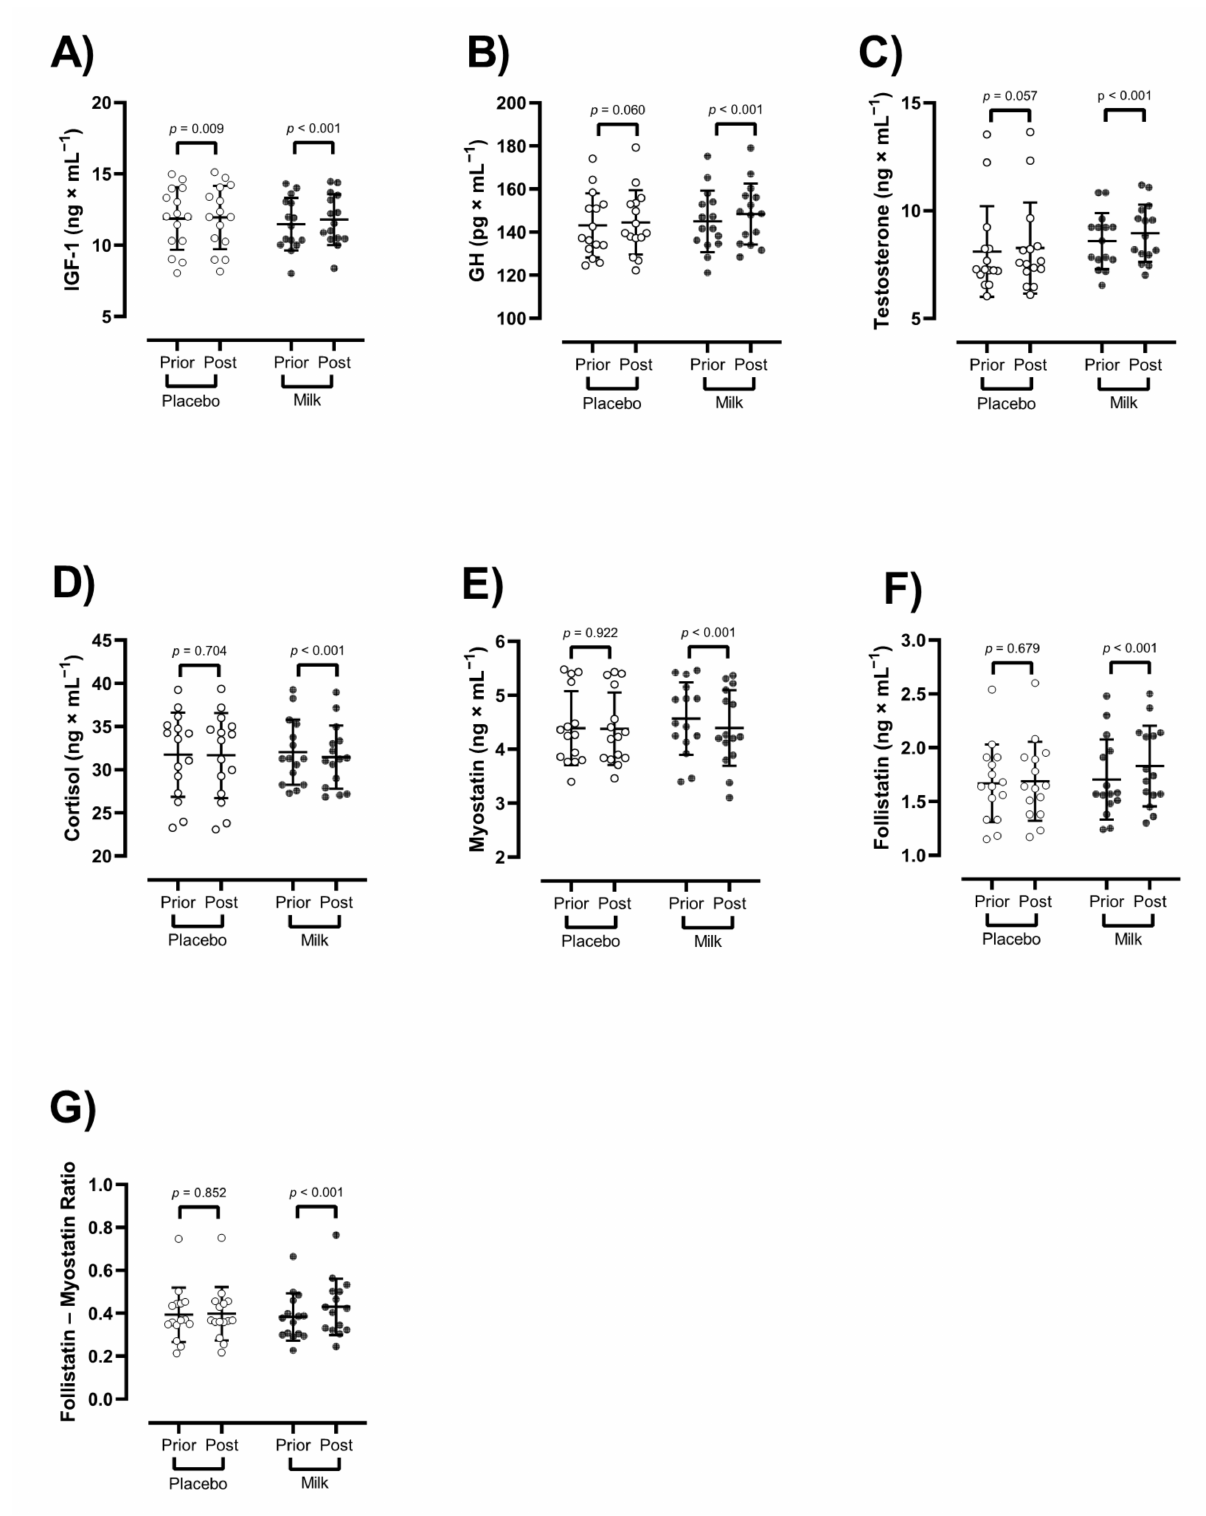
Figure 3. Effect of resistance training and groups on endocrine markers. ( A ) IGF-1 (ng × mL − 1 ), ( B ) GH (pg × mL − 1 ), ( C ) testosterone (ng × mL − 1 ), ( D ) cortisol (ng × mL − 1 ), ( E ) myostatin (ng × mL − 1 ), ( F ) follistatin (ng × mL − 1 ), ( G ) follistatin–myostatin ratio. n = 15 per group, error bars represent standard deviation, open white circles indicate placebo group, closed black circles indicate high-protein diary milk ingestion